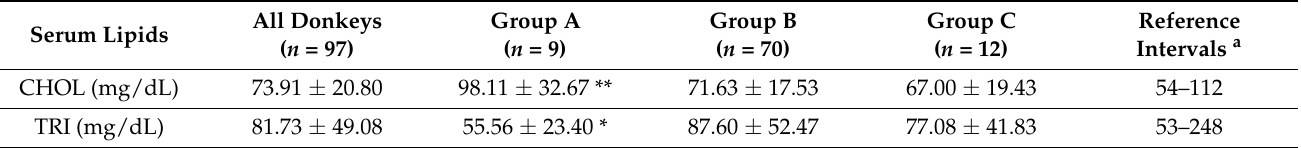
Table 3. Mean ± standard deviation of serum cholesterol and triglycerides in all donkeys (females and males) and in jennies in relation to age (A and B) and pregnancy (Group C).